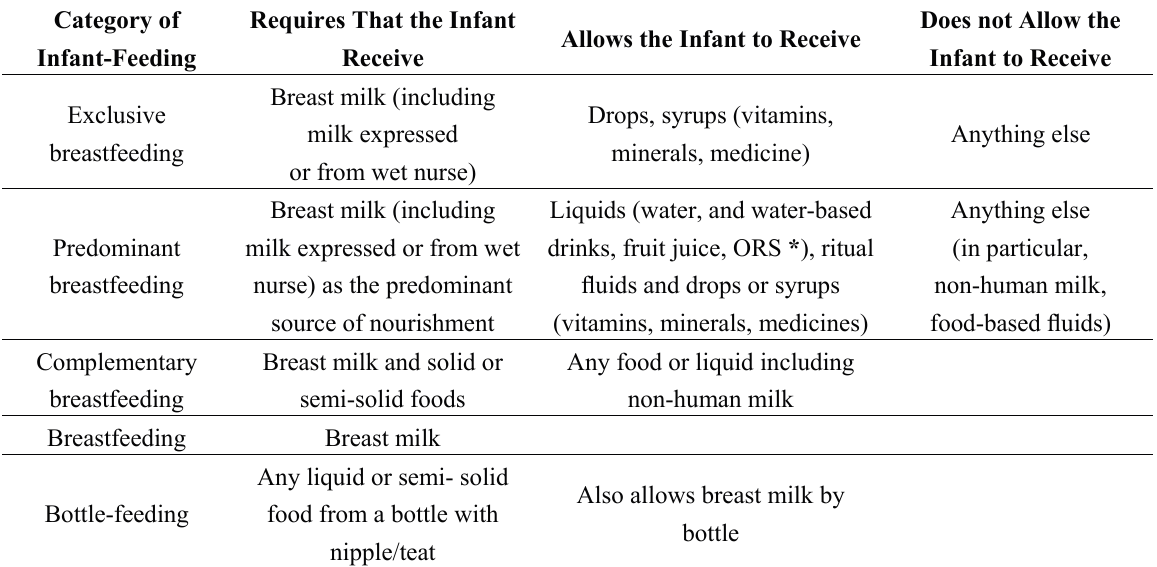
Table A1. Criteria for inclusion in WHO infant feeding categories